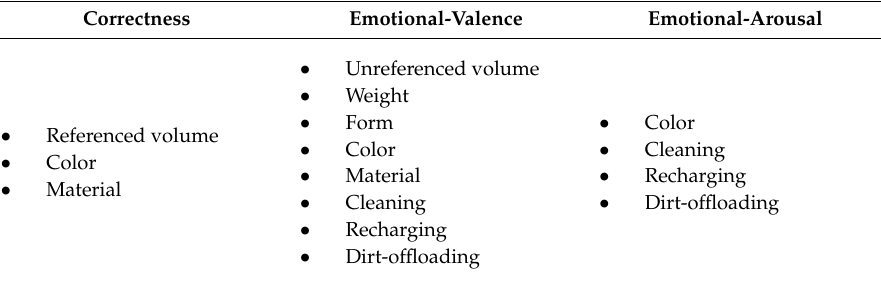
Table 6. Experimental results with significant di ff